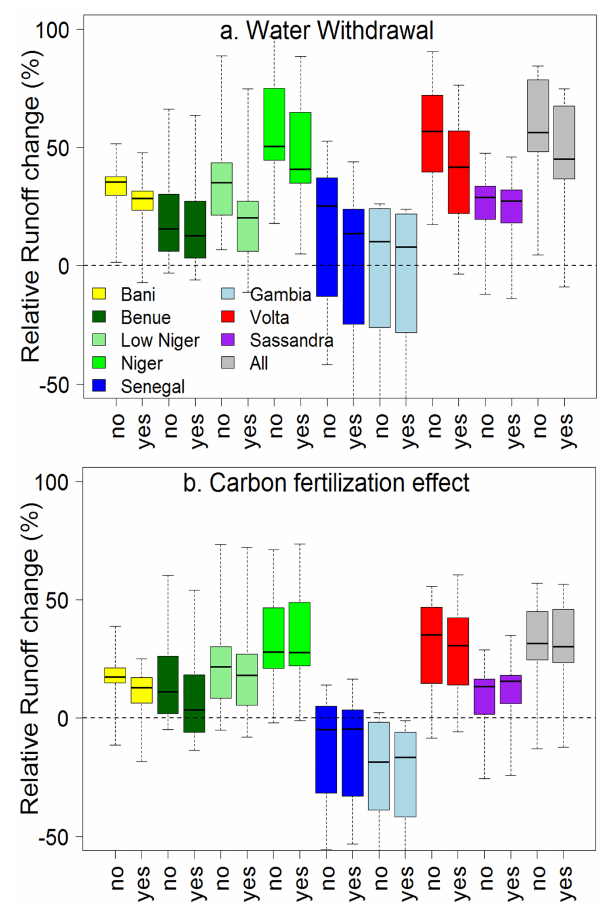
Figure 8. (a) Impact of future water withdrawals on runoff relative change (%) for 8 rivers. (b) Runoff relative change (%) for 8 rivers and 2 different scenarios: (i) taking higher carbon concentration into account (“Yes”) and (ii) with fixed carbon concentration (“No”). Values are from Murray et al.